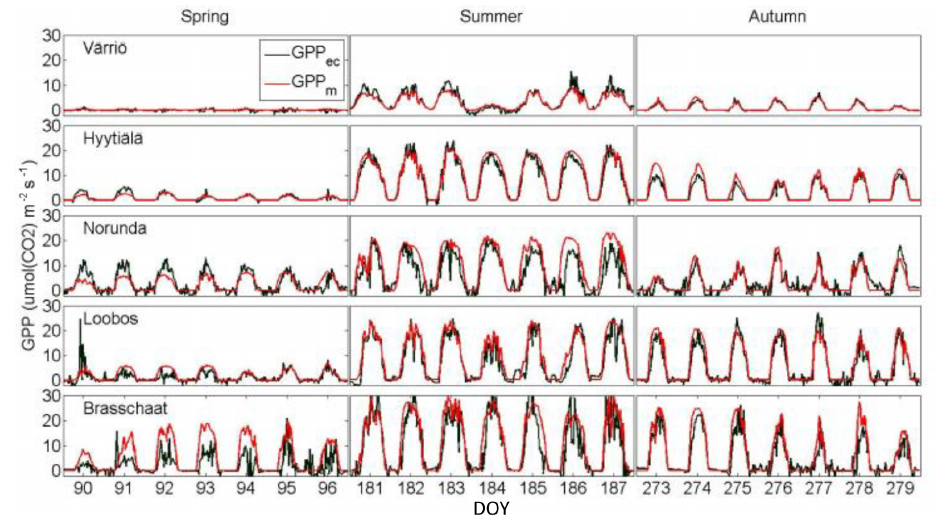
Figure 2. The measured (black) and predicted (purple) photosynthetic CO 2 flux (GPP) between the forest ecosystem and the atmosphere as a function of time in five eddy-covariance-measuring sites in Europe during a week in early spring, summer and autumn.